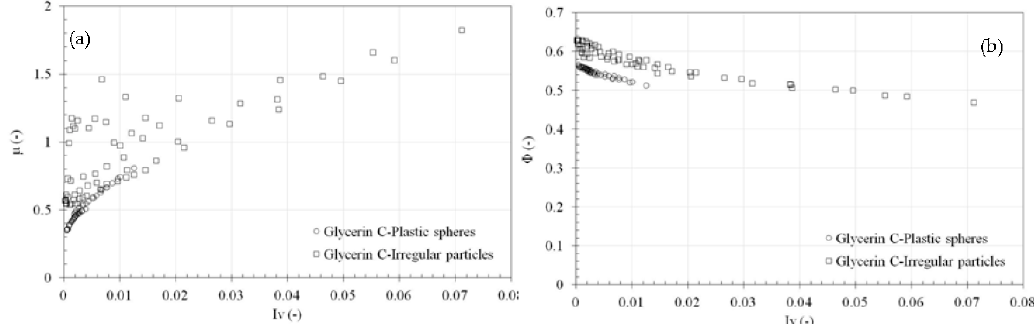
Figure 5. Glycerin C-plastic spheres mixtures and glycerin C-irregular particles mixtures. ( a ) friction coefficient µ as a function of the viscous number I v . ( b ) volume fraction Φ as a function of the viscous number I v .